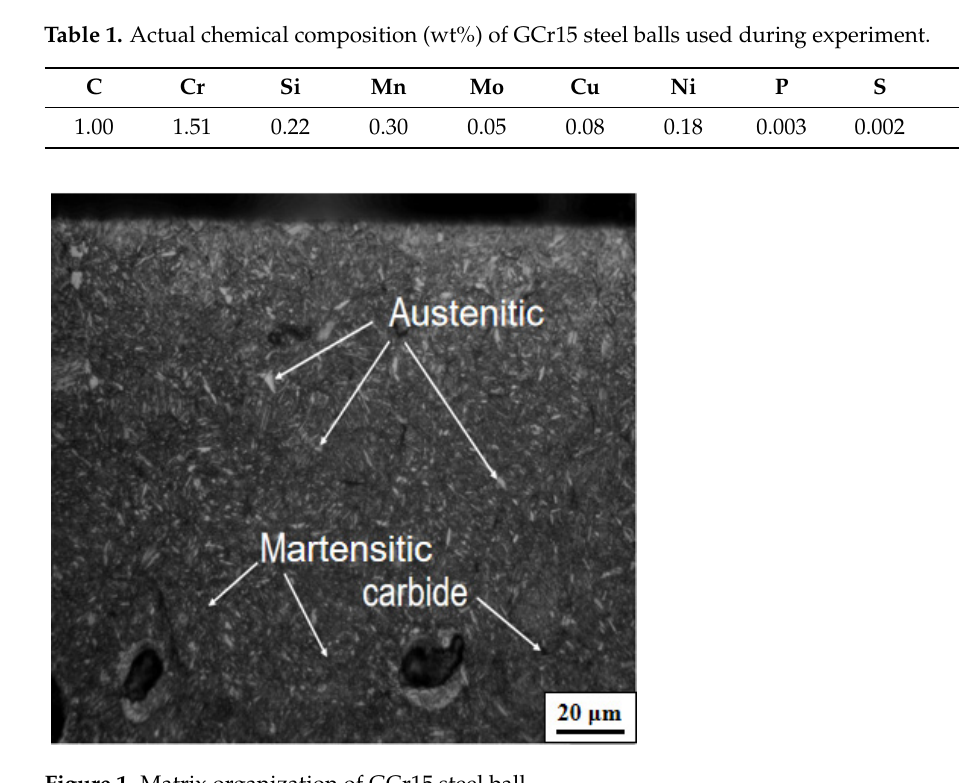
Figure 1. Matrix organization of GCr15 steel ball.